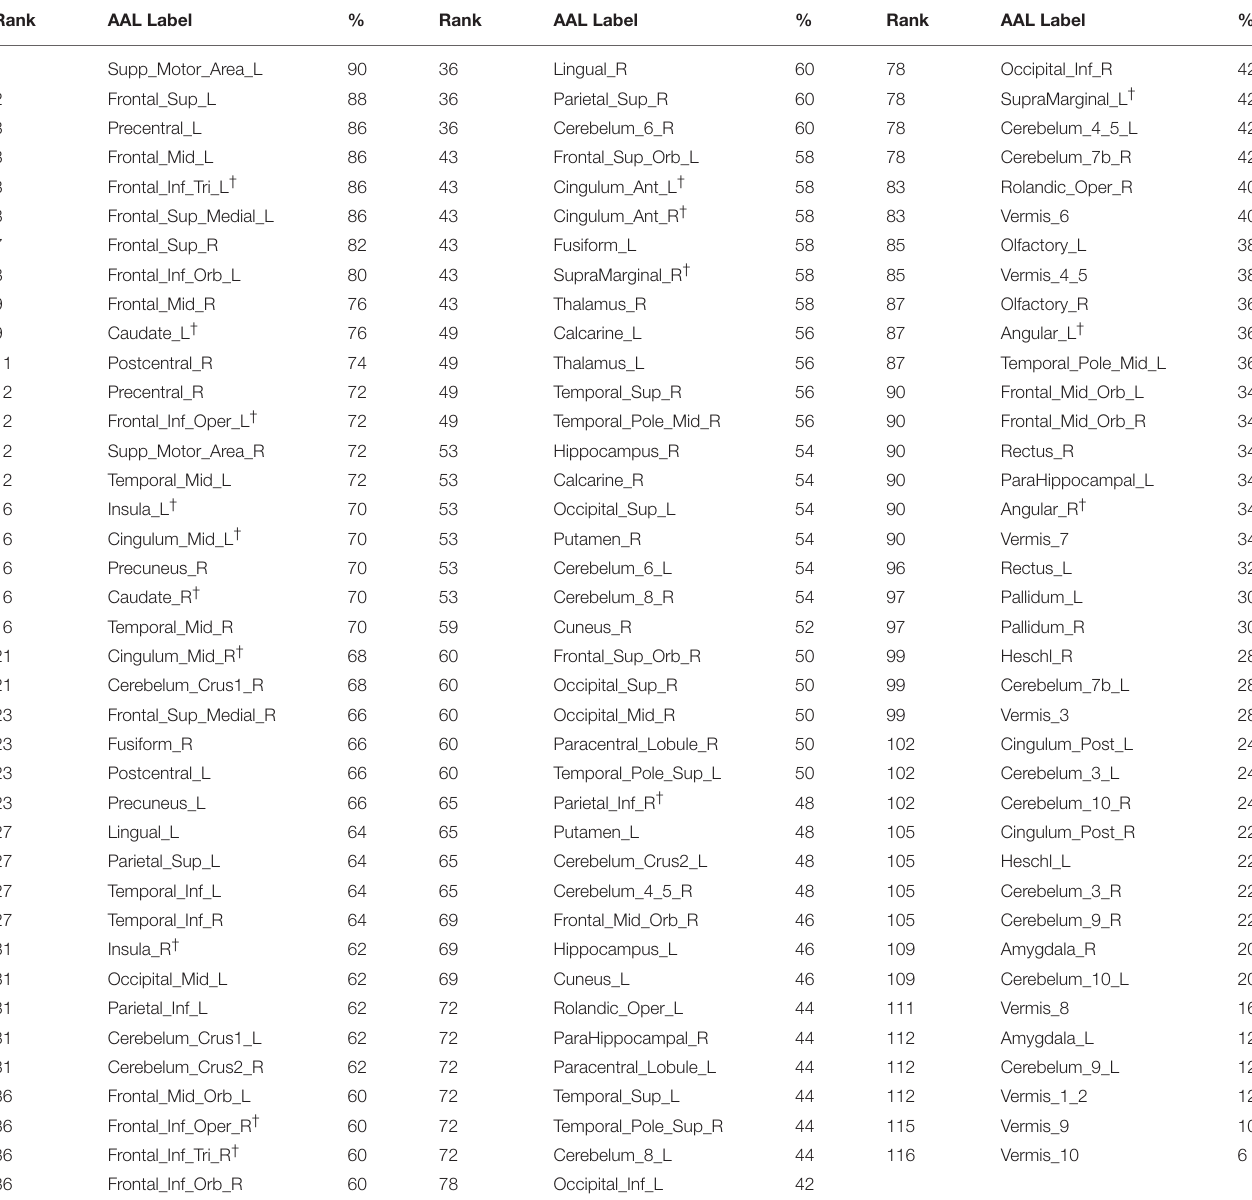
TABLE 1 | Proportion of participants in Hervais-Adelman et al. (2015) with significant (at uncorrected p < 0.01) activation increase for interpreting vs. shadowing in each region of the AAL template.